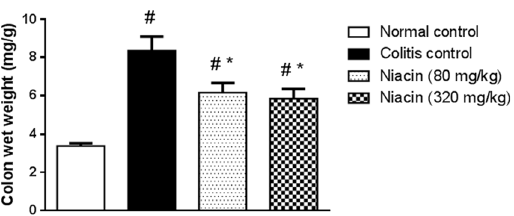
Figure 2. Effect of niacin on colon wet weight in rats with iodoacetamide-induced colitis. Data are expressed as means ± SEM of 8 animals. # P ≤ 0.05 vs. normal control, * P ≤ 0.05 vs. colitis